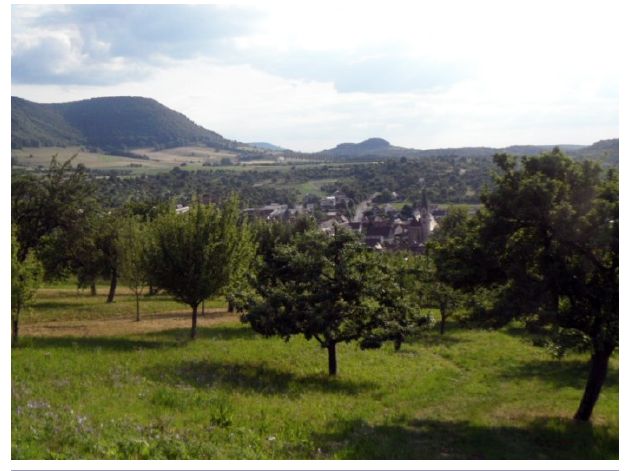
Fig. 4 . Current landscape character in the Owen area. Source: F. Wolff